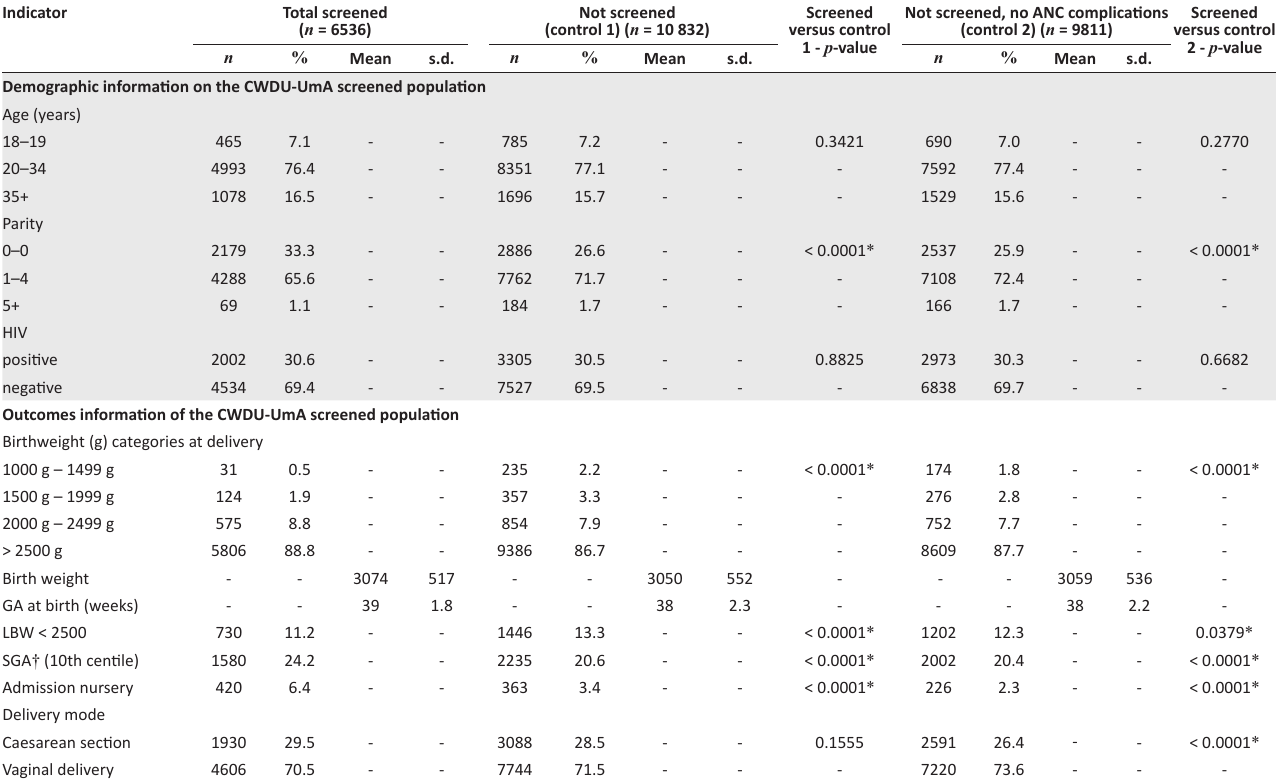
TABLE 1a: Comparison of the continuous wave Doppler ultrasound of the umbilical artery screened group and control groups 1 and 2.